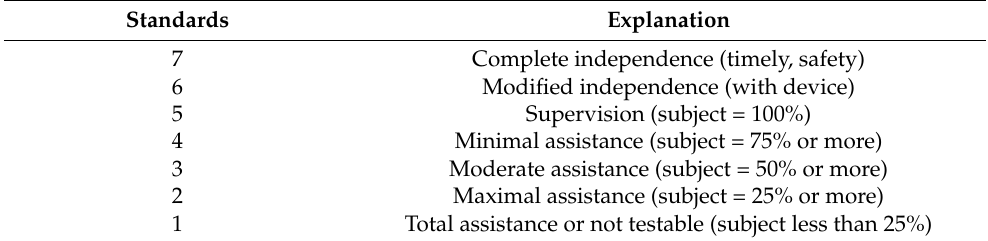
Table 2. Standards of each score for the Functional Independence Measure